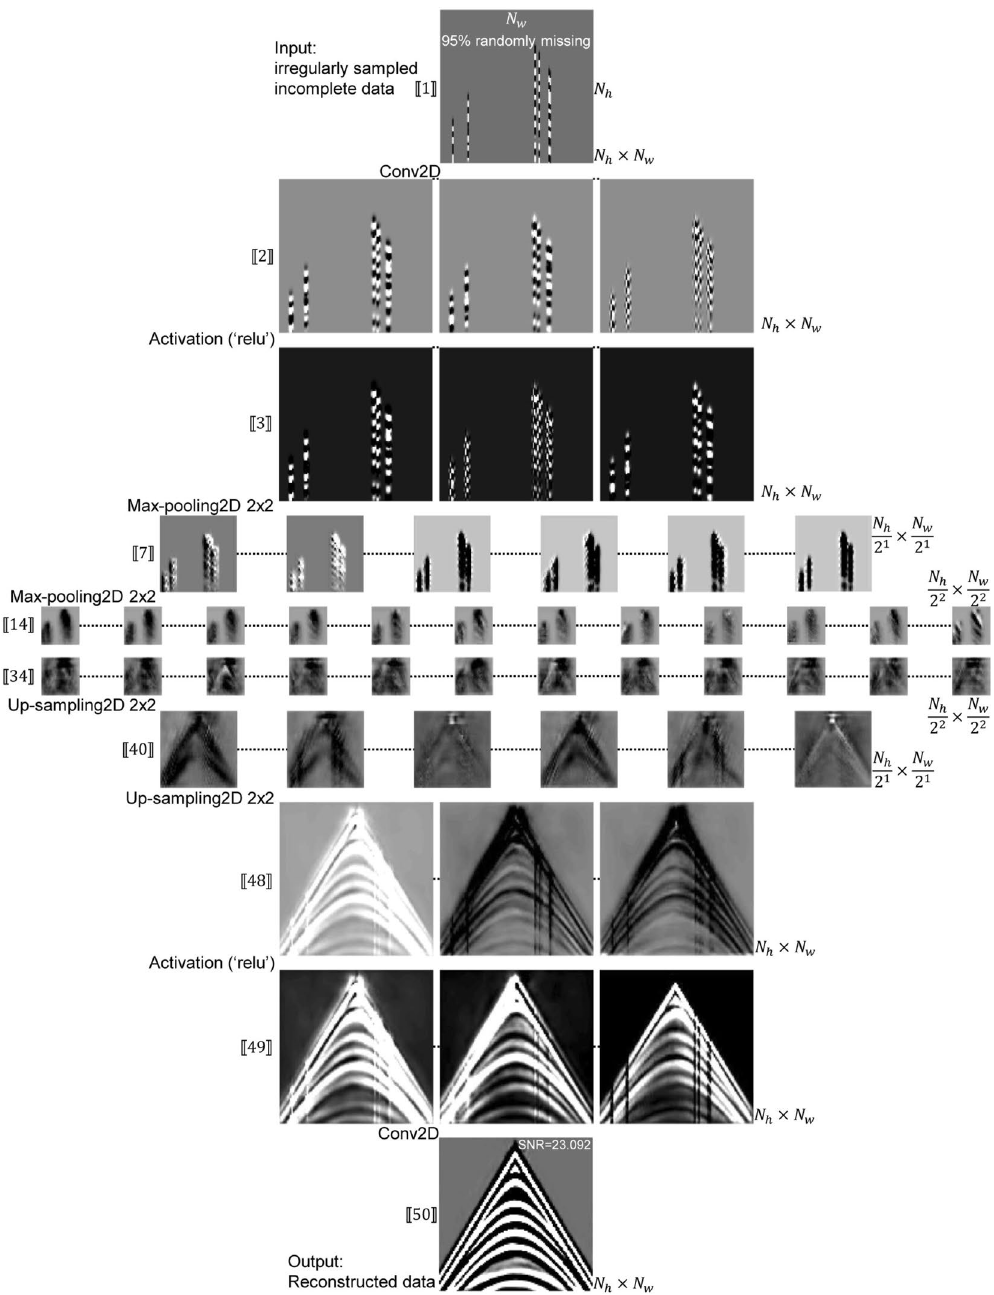
Figure 2. Feature maps for a randomly sampled data set going through the trained model. Numbers in [[ ⋅ ]] are labelled according to Table 1, which are consistent with those shown in Fig. 1. The symbol “...” implies the omitted feature